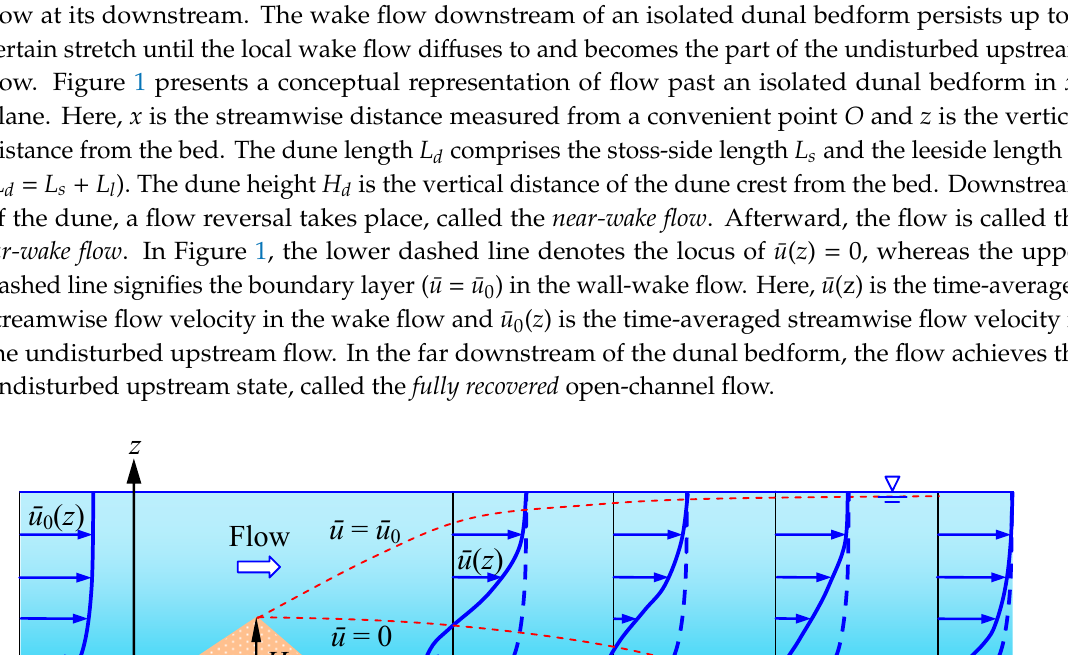
Figure 2. Photographs of isolated dunal bedforms in ( a ) Run 1 and ( b ) Run 2. Flow direction is from left to right.